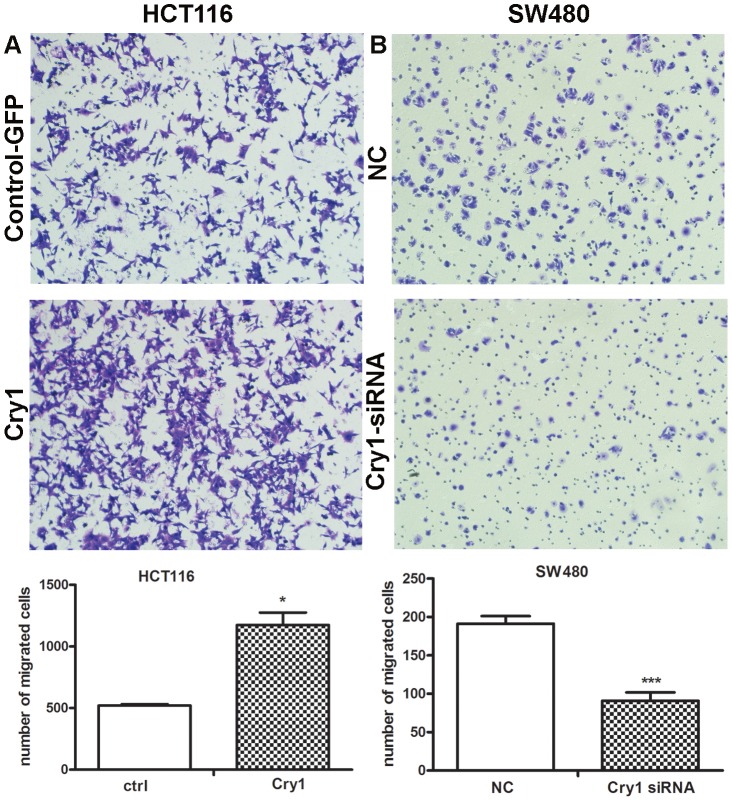
Cry1 promotes CRC cells migration.(A) Migration assays of HCT116 cells transfected with Cry1 or GFP control. (n = 3,*, p = 0.019) (B) Migration assays of SW480 cells transfected with Cry1-siRNA or negative control. (n = 3, ***, p<0.001). Representative images are shown above, and the average number of cells per field at the indicated time points are shown below. Data are the mean of three independent experiments.